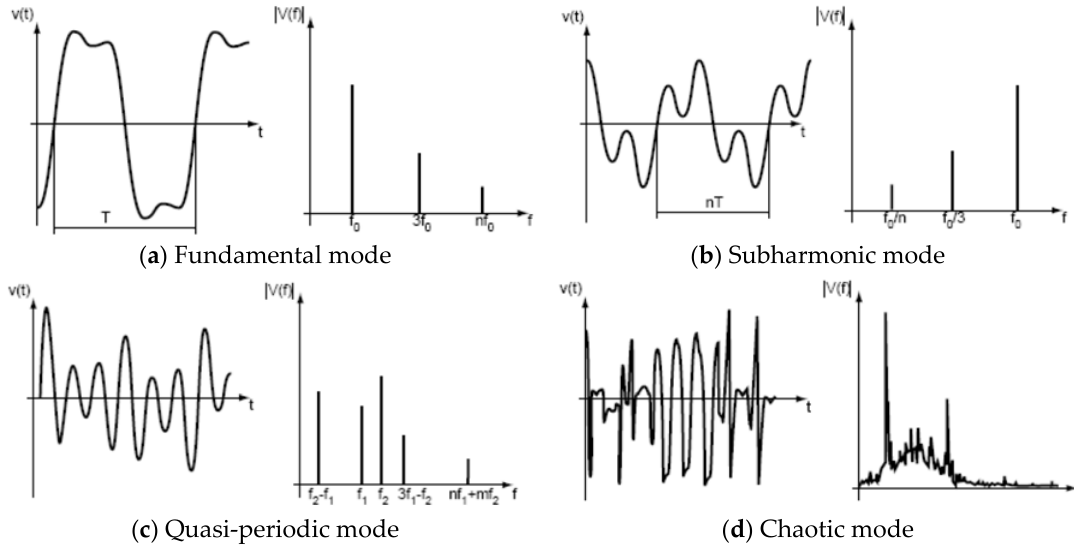
Figure 2. The ferroresonance modes and their frequency responses [30].